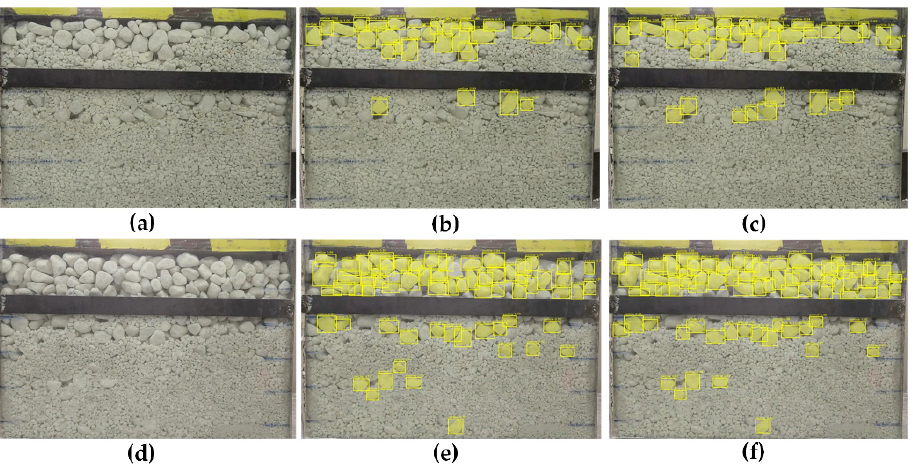
Figure 7. Experiment effect images of instance segmentation: ( a ) shows an image with a mixing degree of 40, and the proportion of coarse particles is 25; ( b ) shows the segmentation effect of ( a ) with the standard Mask R-CNN; ( c ) shows the segmentation effect of ( a ) with the improved Mask R-CNN; ( d ) shows an image with a mixing degree of 60, and the proportion of coarse particles is 50; ( e ) shows the segmentation effect of ( d ) with the standard Mask R-CNN; ( f ) shows the segmentation effect of ( d ) with the improved Mask R-CNN.